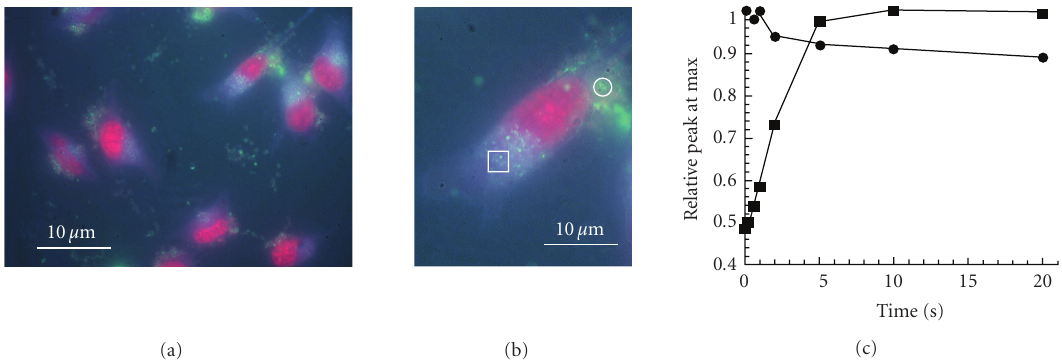
Figure 5: Subcellular di ff erences in QD-dopamine fluorescence. (a) Image under DAPI filter of cells labeled with QD-dopamine (and with SYTO red to show nuclei). The green regions (540–580 nm emission) show QD fluorescence but no dopamine fluorescence. The blue ar- eas (460–500 nm emission) show dopamine fluorescence and no initial QD fluorescence; QD fluorescence appears after UV illumination. Double-labeling experiments identified the green areas as lysosomes (not shown) or as regions exterior to the cell. (b) Closeup of a single cell from panel A showing blue spots (square) and green spots (circle). (c) Time course of QD peak fluorescence under UV illumination (QD filter) for a blue region (squares) and a green region